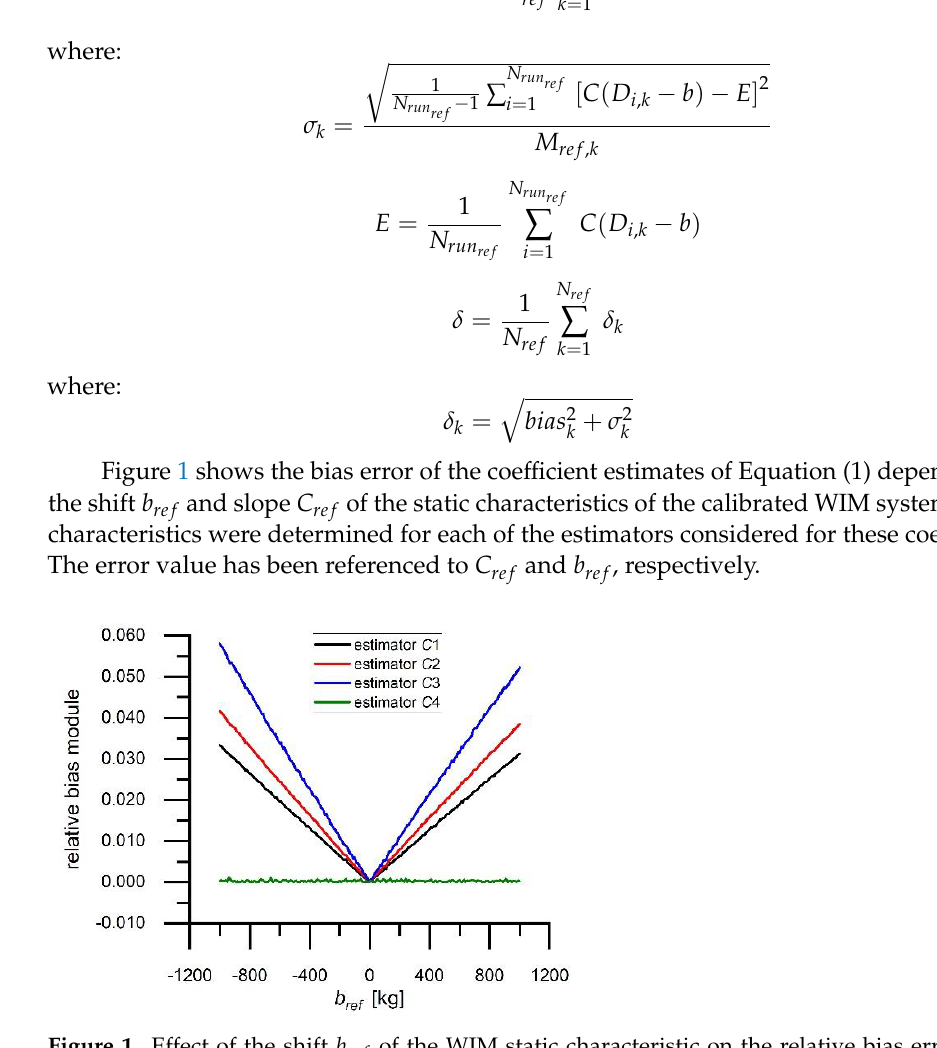
Figure 1. Effect of the shift b ref of the WIM static characteristic on the relative bias error of the estimates of the C calibration factor for different calibration algorithms and C ref = 1 .